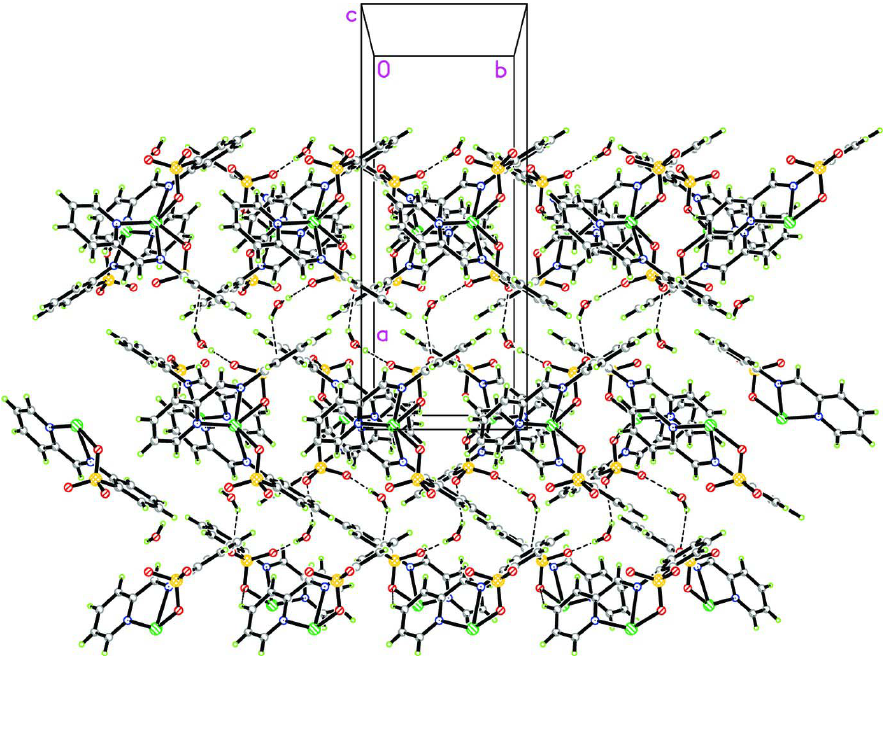
Figure 1 An ellipsoid plot (30% probability) showing the numbering scheme. Dashed lines indicate hydrogen bonds. Symmetry code: 1# - x + 1, y , - z +